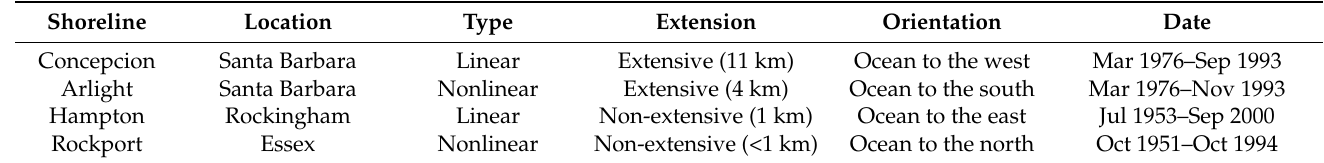
Figure 1. General location and study coastal stretches: Concepcion and Arlight shorelines, Santa Barbara (CA); Hampton shoreline, Rockingham (NH); Rockport shoreline, Essex (MA). Table 1. General characteristics of shorelines used in the validation